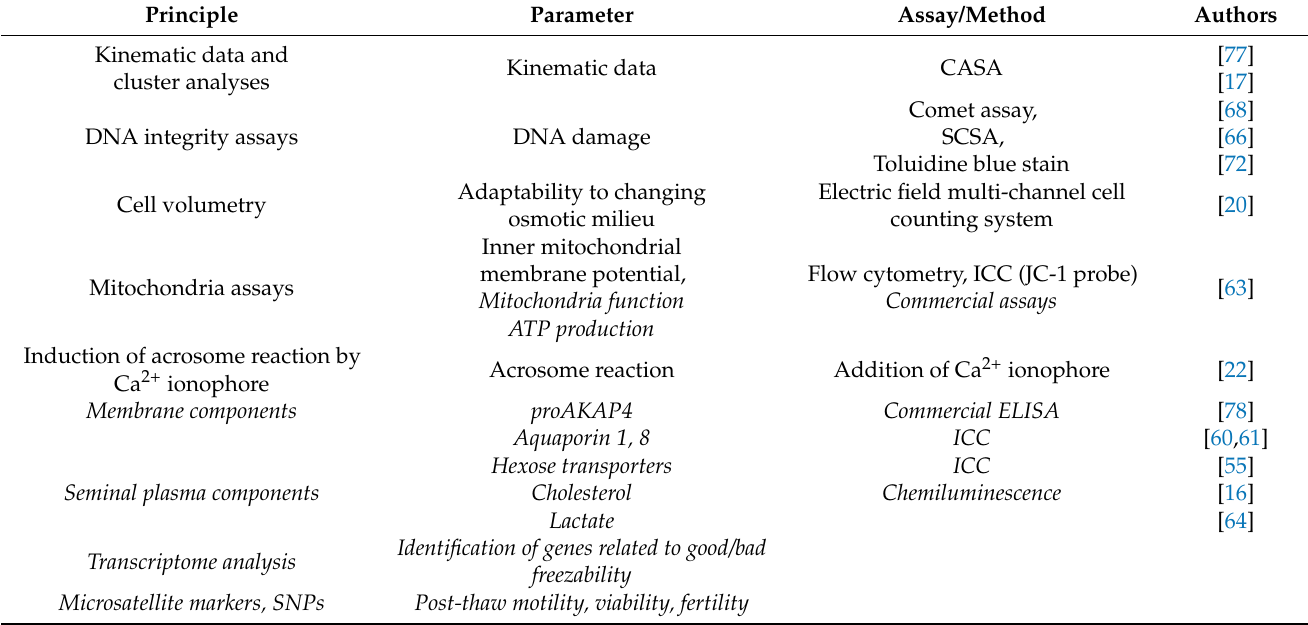
Table 1. Predictors of freezability of canine